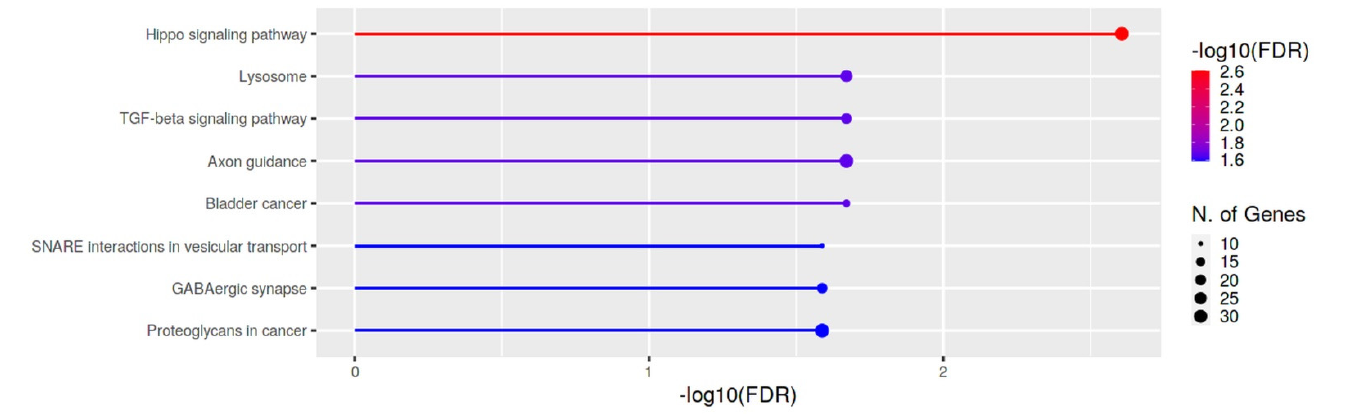
Figure 4. KEGG enrichment analysis of KEGG pathways relative to predicted target genes of miR- 11400. Bar plots depict the significantly enriched terms ordered by p-value.